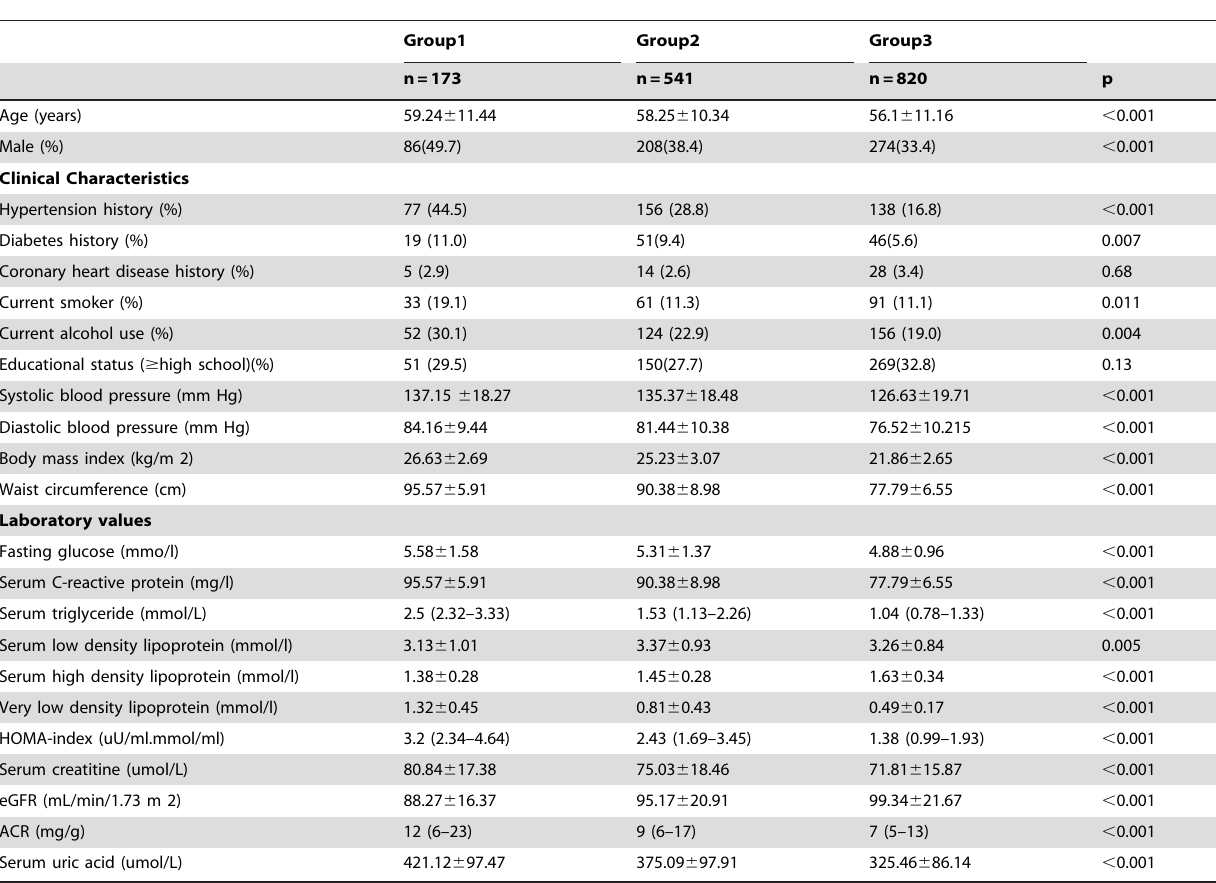
Table 1. Baseline characteristics of the participants based on HW phenotype.